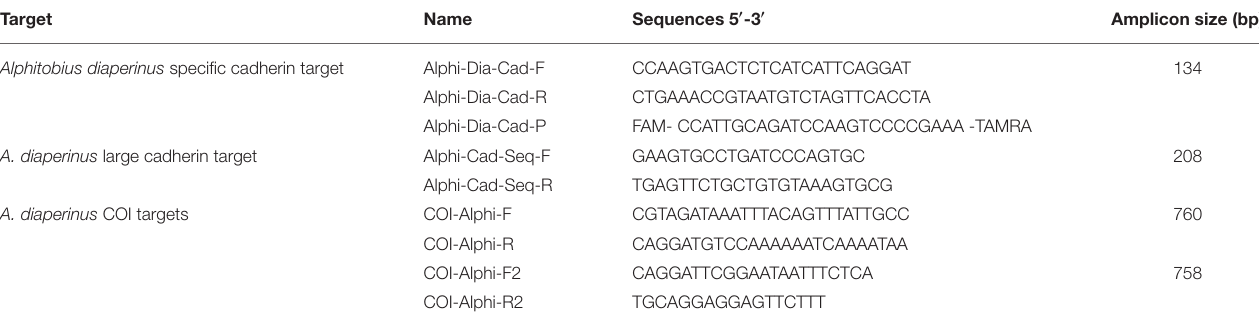
TABLE 1 | Primers and probe used within this